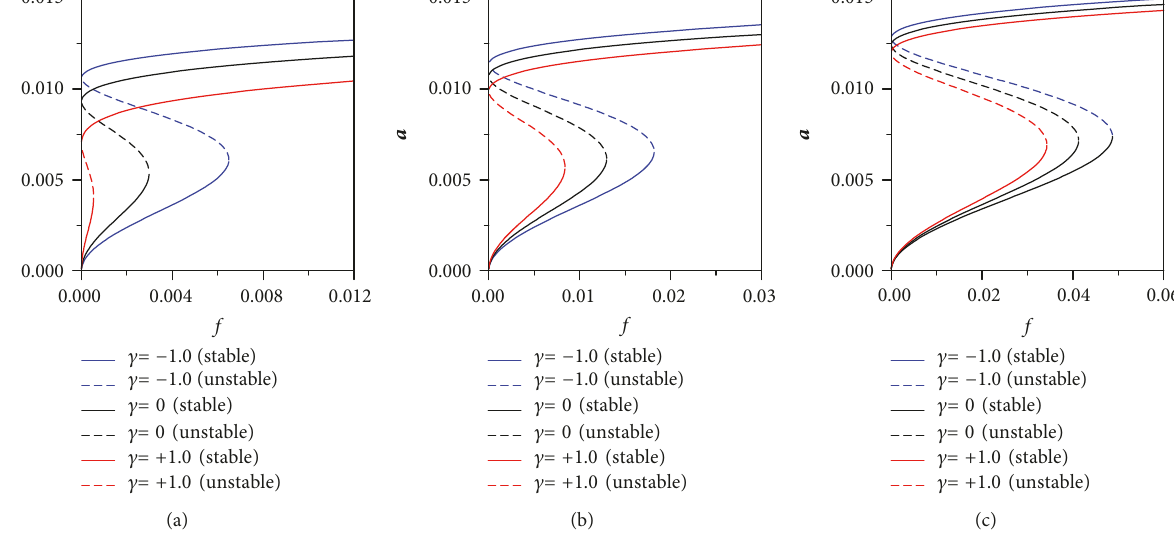
the system exhibits the hardening-spring behavior due to the cubic nonlinearity term, and all these curves bend to the right side. As to the hinged-hinged boundary condition as shown